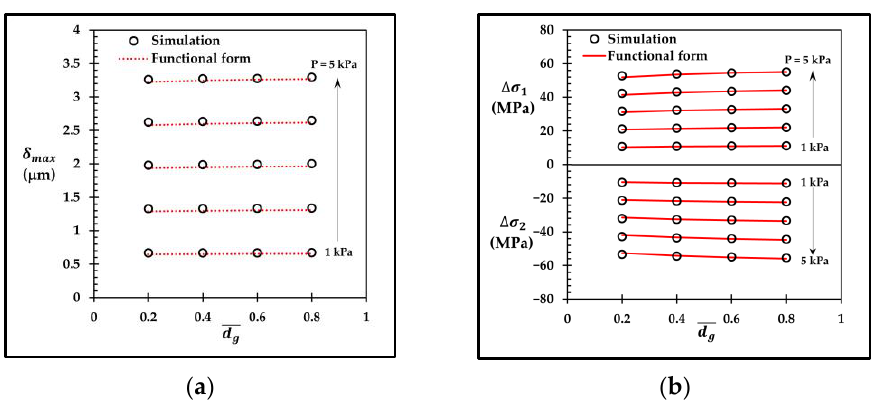
Figure 25. Comparisons of simulation results with ( a ) functional form of maximum deflection 𝛿 𝑚𝑎𝑥,𝐿𝐺2−𝐿𝑇−𝑇𝑜𝑝 and ( b ) functional forms of averaged stress differences ∆𝜎 1,𝐿𝐺2−𝐿𝑇−𝑇𝑜𝑝 and ∆𝜎 2,𝐿𝐺2−𝐿𝑇−𝑇𝑜𝑝 .